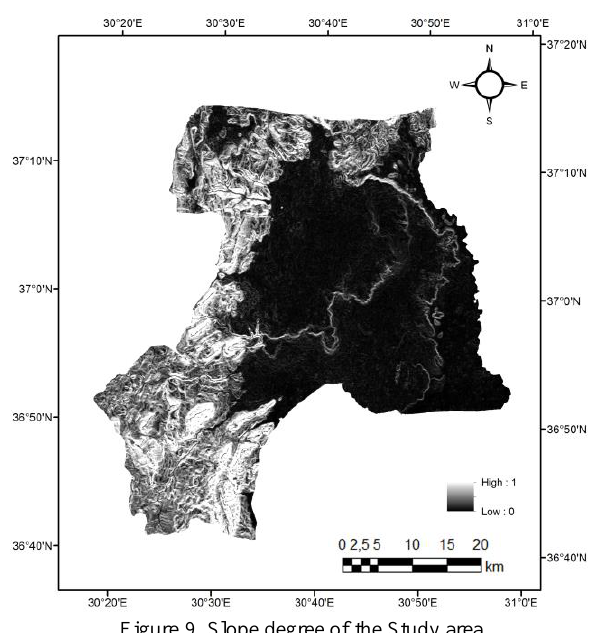
Figure 9. Slope degree of the Study area